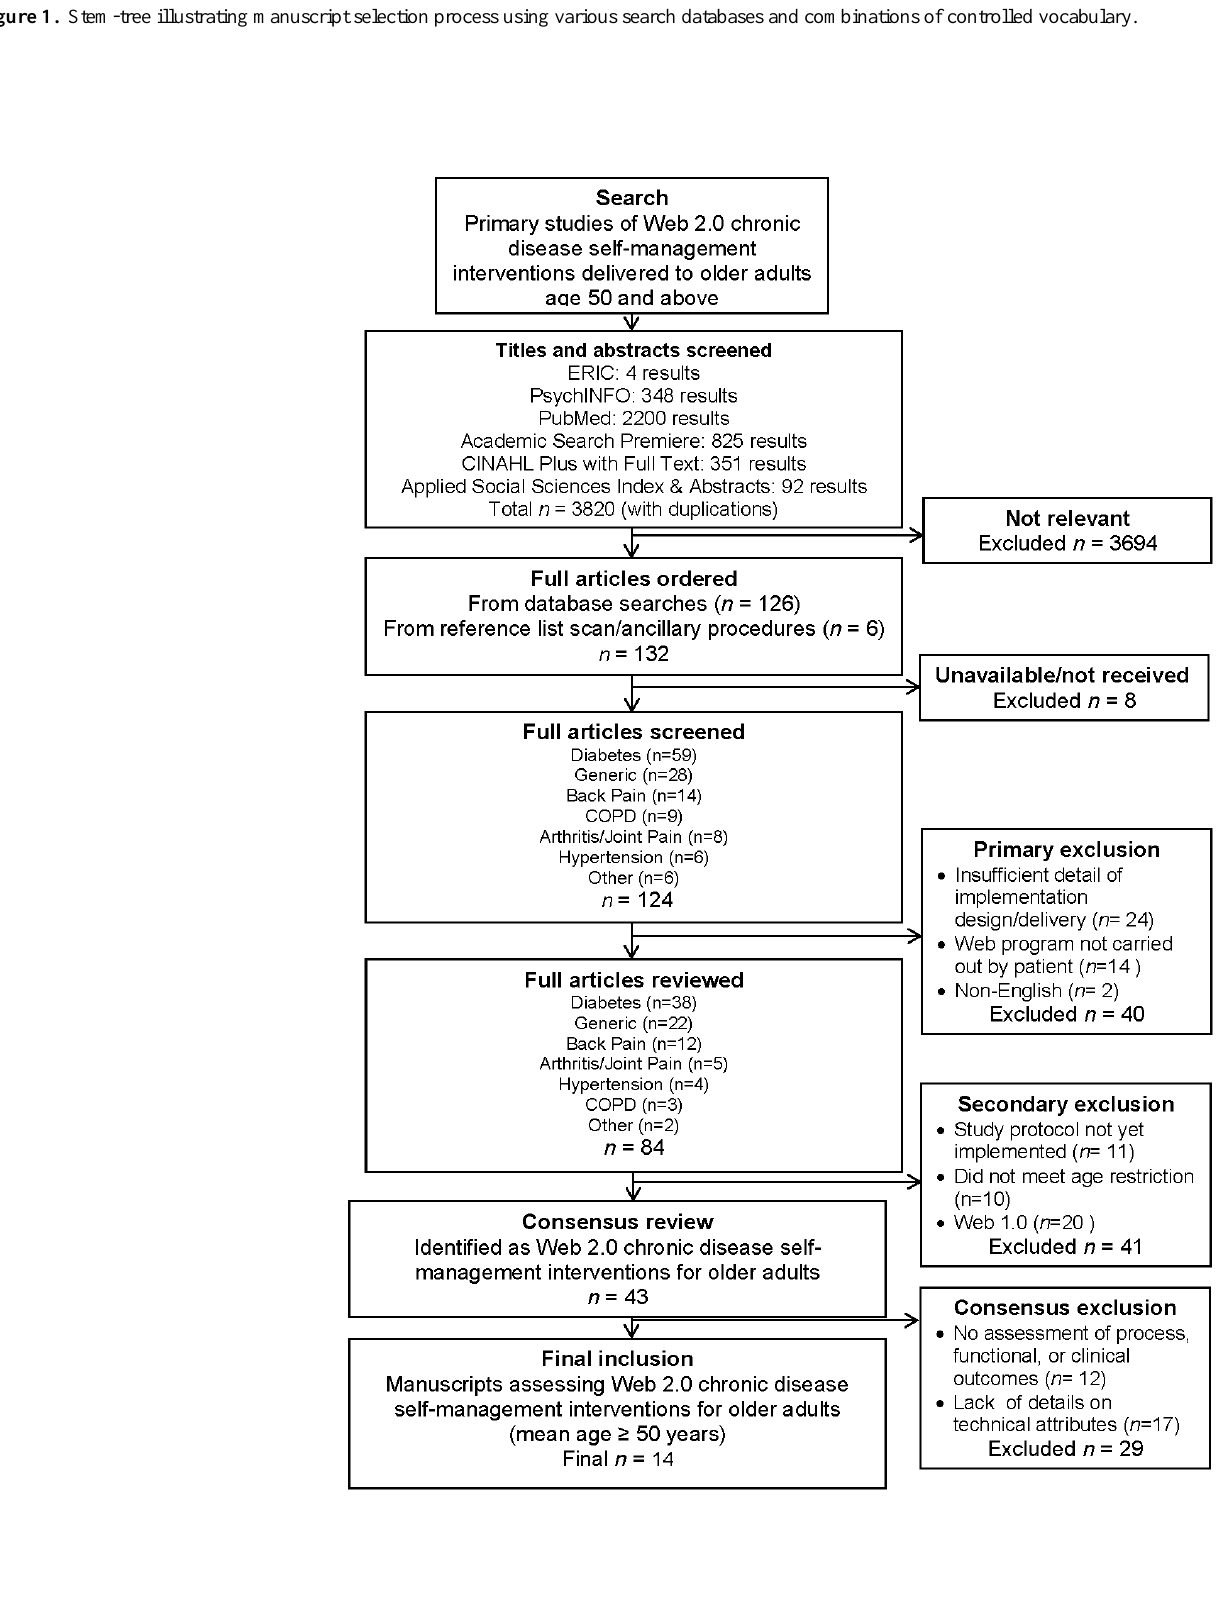
Figure 1. Stem-tree illustrating manuscript selection process using various search databases and combinations of controlled